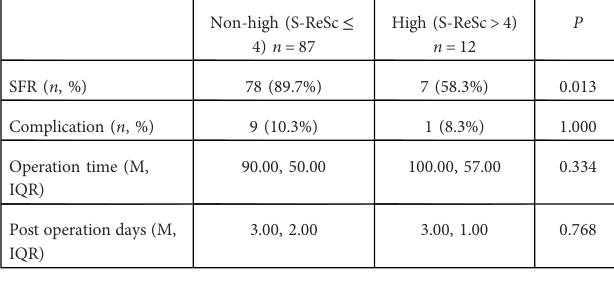
TABLE 2 Comparison of non-high group VS high group for multiple